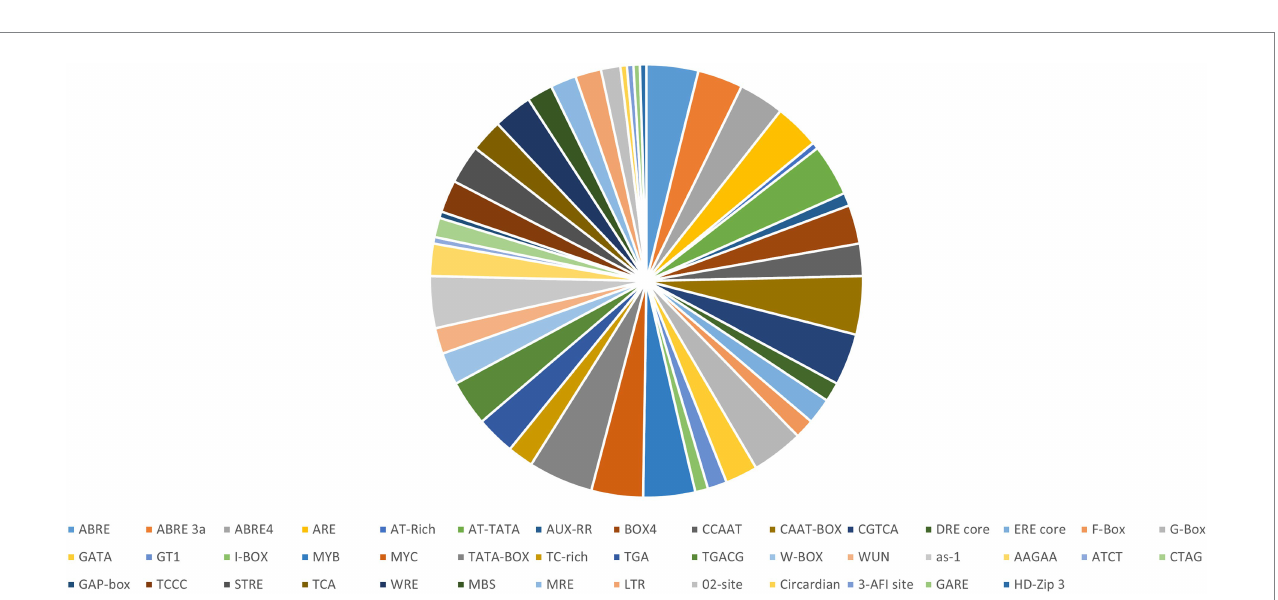
FIGURE 3 Pie distribution of AtNF-YB cis- elements identified using PLANTCARE, represented according to the percentage of prevalence of major cis- elements in the promoter regions of the AtNF-YB family of